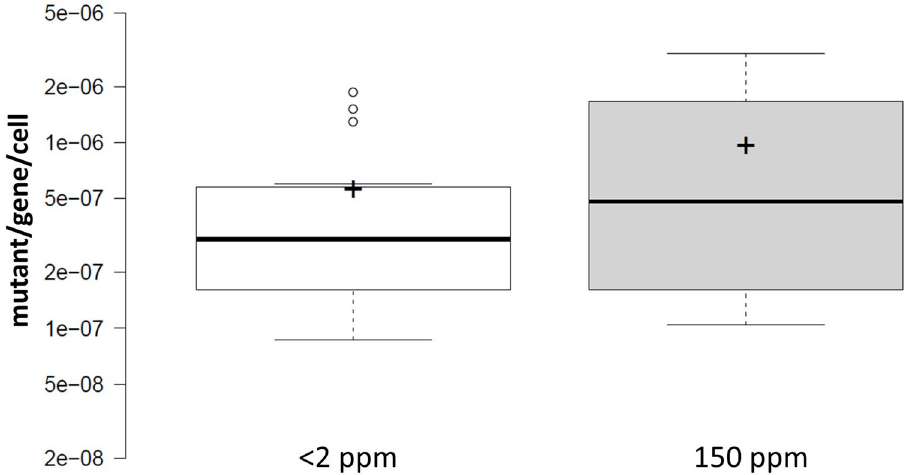
Fig 5. Combined effect of D on the mutation frequencies measured in one of three genes ( cycA , ackA or galK ) of E . coli . Center lines show the medians; box limits indicate the 25th and 75th percentiles as determined by R software; whiskers extend 1.5 times the interquartile range from the 25th and 75th percentiles, outliers are represented by dots; crosses represent sample means. The medians are not significantly different ( U = 94, z = -0.74, n 2 = n 150 = 15, P = .46, applying a Mann-Whitney